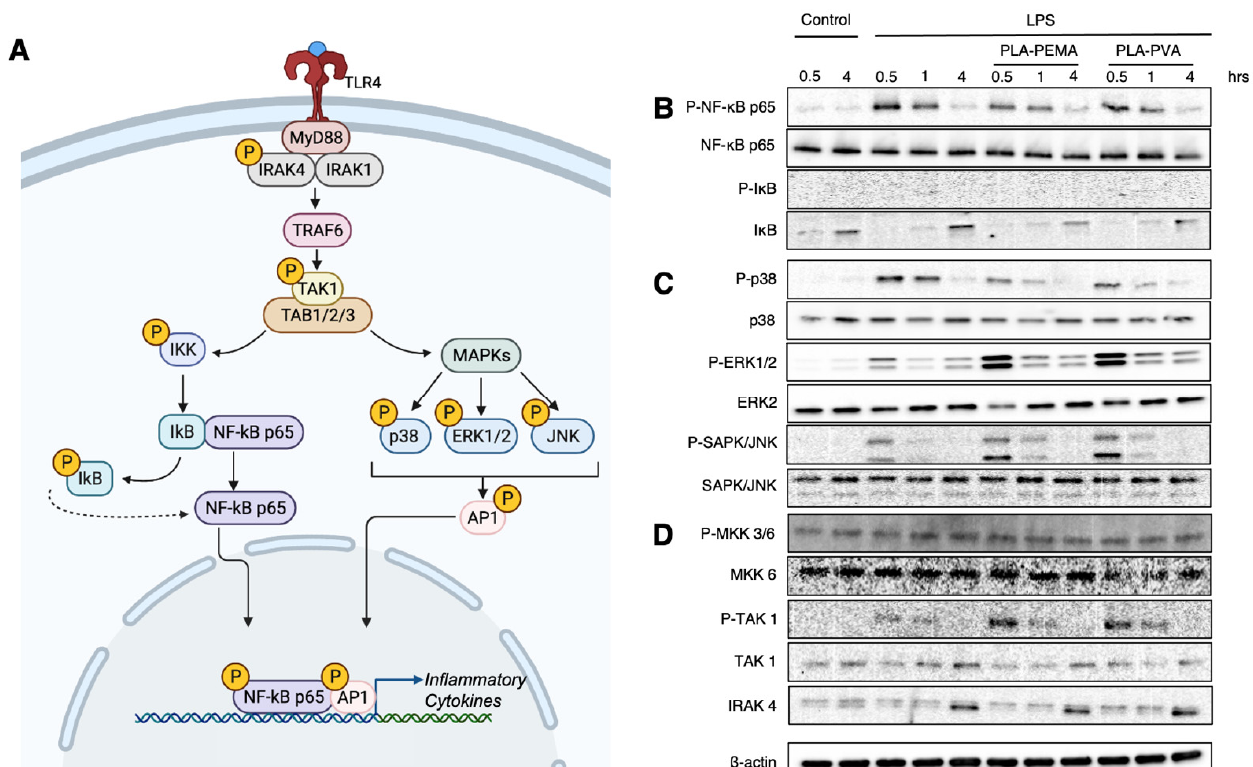
Figure 4. Both iNPs suppress NF- κ B p65 and p38 MAPK activation, although at different rates. ( A ) TLR4 activation upon LPS binding triggers a complex signaling cascade where two key nodes of activity involve activation of NF- κ B p65 and p38 MAPK to initiate downstream inflammatory cytokine expression. Following PLA-PVA (300 µg/mL) and PLA-PEMA (300 µg/mL) treatment, cells were then stimulated with LPS (100 ng/mL) for 0.5, 1, or 4 hrs. ( B ) Samples were then immunoblotted for key NF- κ B proteins: phospho-NF- κ B p65 (Ser536), total NF- κ B p65, phospho-I κ B (Ser32), and total I κ B. ( C ) These samples were also immunoblotted for a variety of MAPKs: phsopho-p38 (Thr180/Tyr182), total p38, phospho-ERK1/2 (Thr202/Tyr204), total ERK2, phospho-SAPK/JNK (Thr183/Tyr185), and total JNK. ( D ) Finally, to address potential impacts of iNPs on upstream signaling proteins, these samples were immunoblotted for phospho-MKK3 (Ser189/)/MKK6 (Ser207), total MKK6, phospho-TAK1 (Thr184/187), total TAK1, IRAK4, and β -Actin. Schematic in ( A ) created with BioRender.